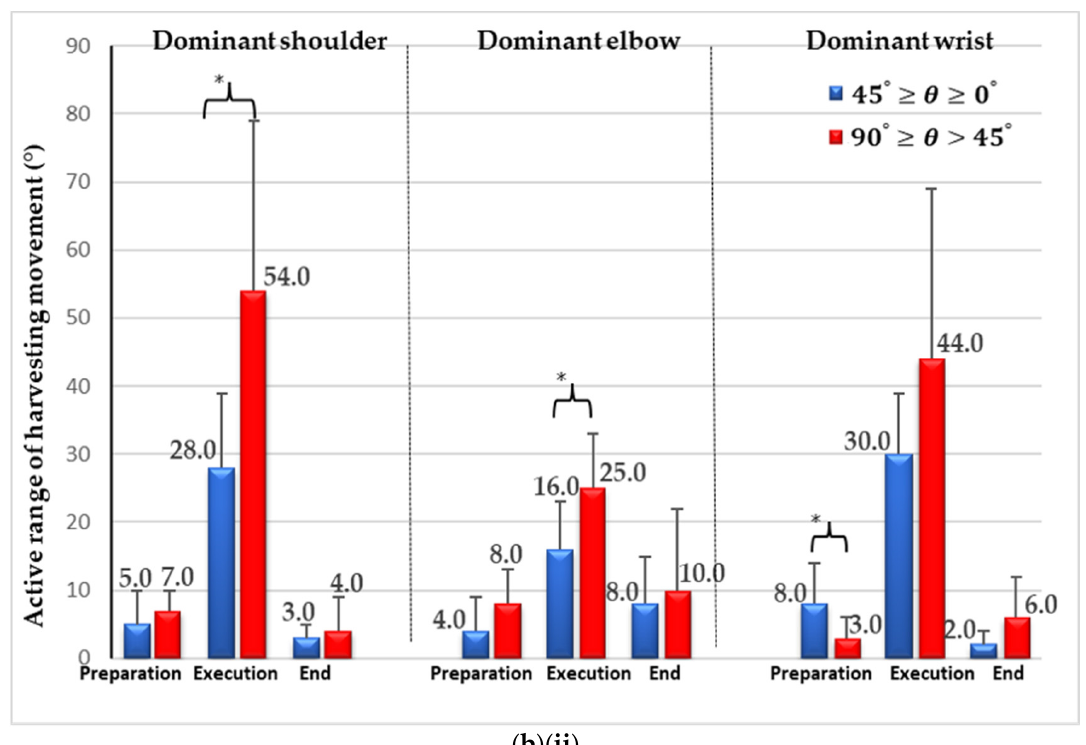
Figure 9. ( a ) Maximum posture range of harvesting movements and ( b ) active range of harvesting movements during the three phases of the push-pull-cutting movement of twenty participants by initial dominant shoulder group for ( i ) the support arm and ( ii ) the dominant arm. The asterisk * denotes statistically significant differences.